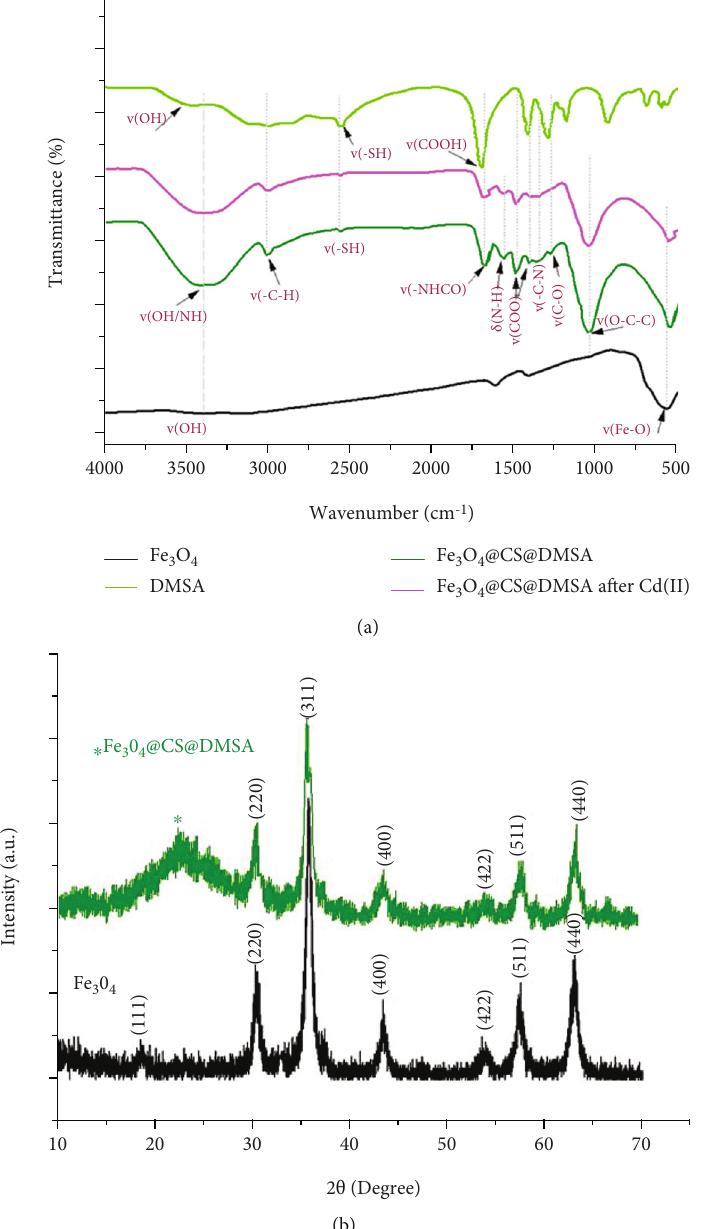
Figure 1: FTIR spectra of (a) Fe